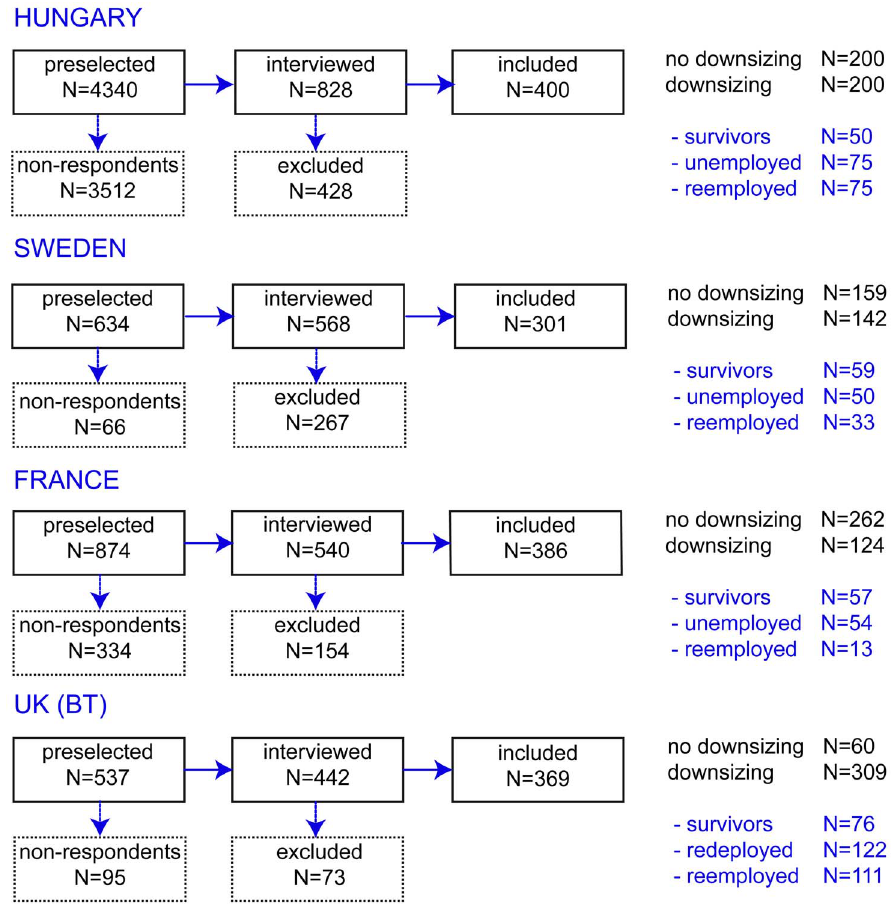
Figure 1. Flow chart showing selection and participation in Restructuring Survey.